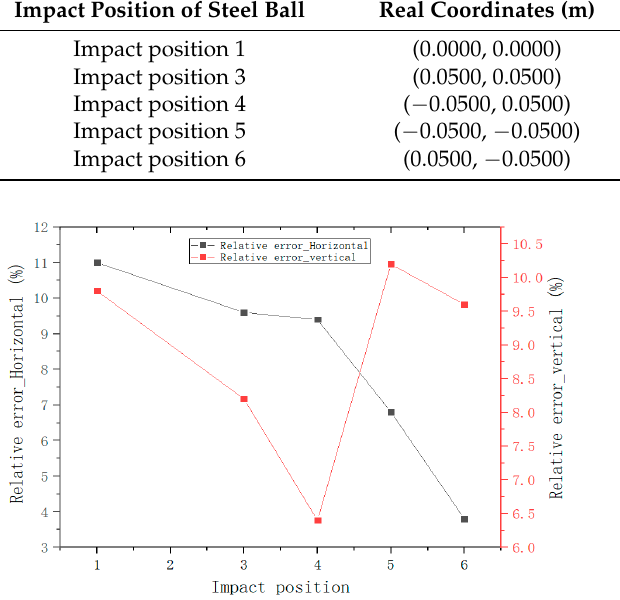
Figure 21. The relative errors of the impact location estimation.